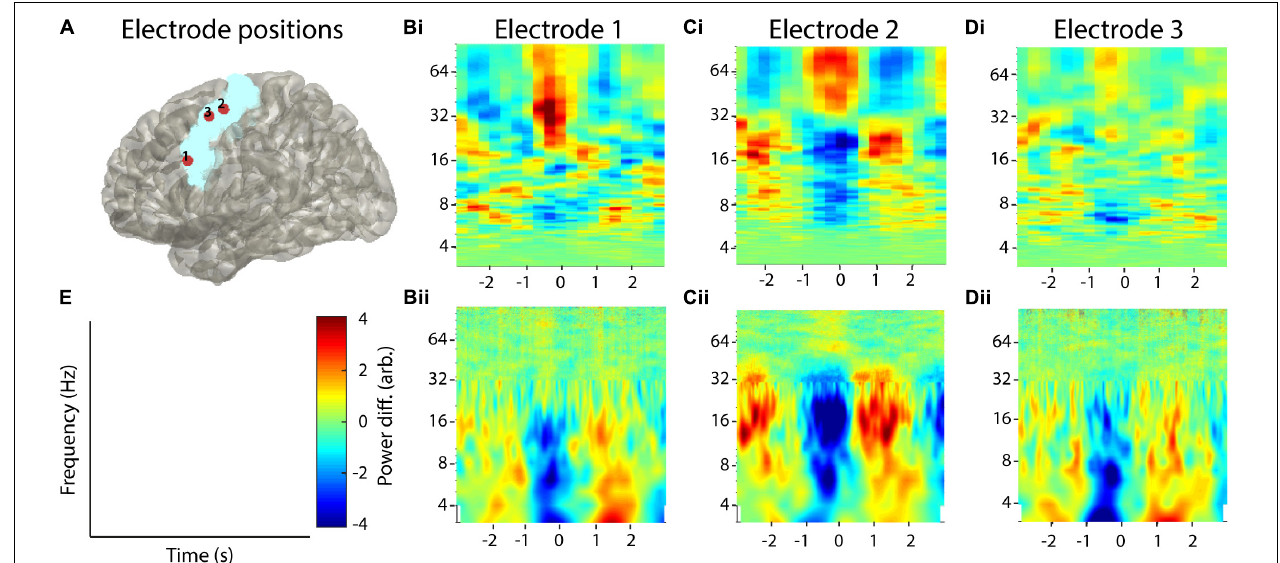
FIGURE 10 | Example application on real invasive EEG data. (A) Selected electrodes in the motor area of one patient with epilepsy. The blue area indicates the precentral gyrus located with the AAL atlas in FieldTrip. (Bi–Di) Recurrence analysis of three example electrodes. Plots have been convolved with a 5 × 5 smoothing kernel for visualization purposes. (Bii–Dii) Corresponding combined multitaper-wavelet analysis of the same electrodes. All power values were normalized with respect to the total power of the analyzed time window. (E) Colorbar and axis labels for Subfigures (B–D) .